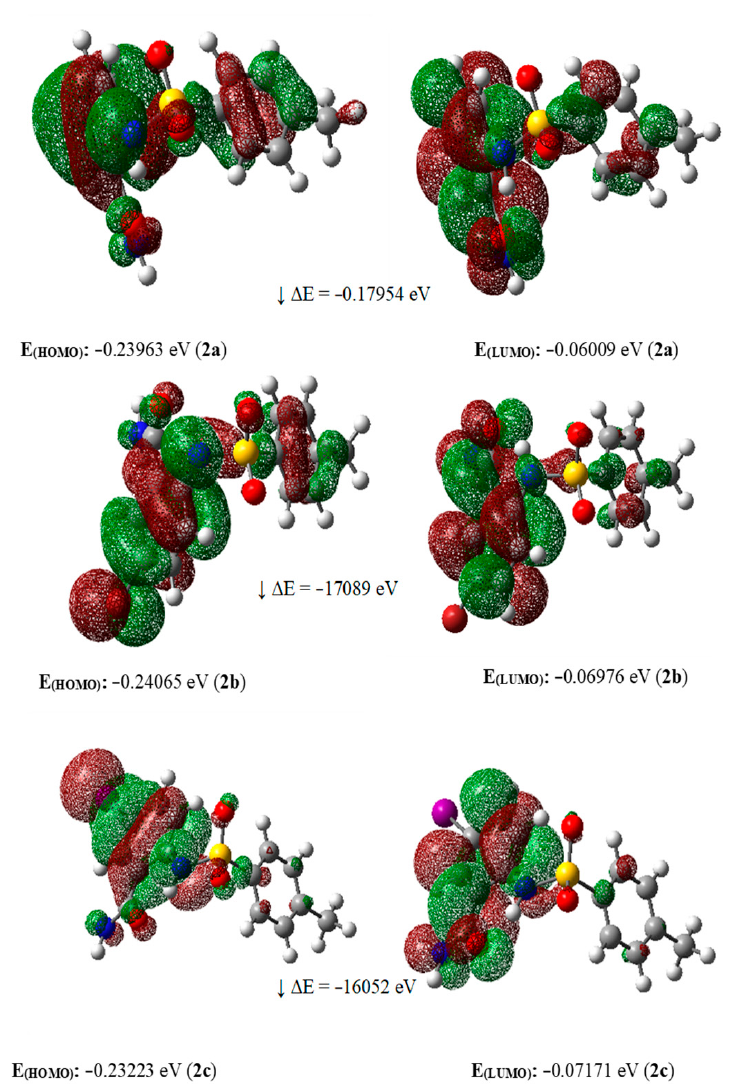
Figure 5. HOMO–LUMO distribution of 2a , 2b and 2c , and the energy gap.